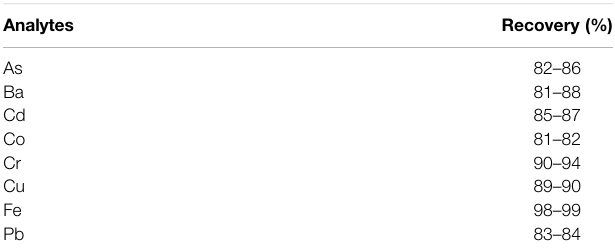
TABLE 2 | Spike and recovery